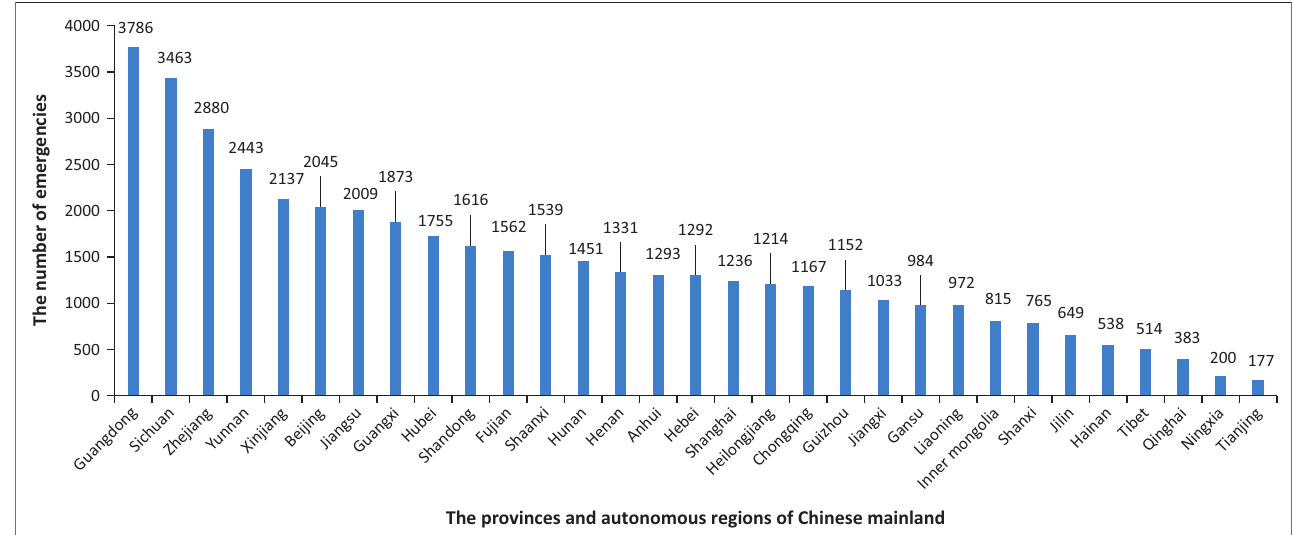
FIGURE 3: Statistics on the number of emergencies in various regions of Chinese mainland (2009–2018).